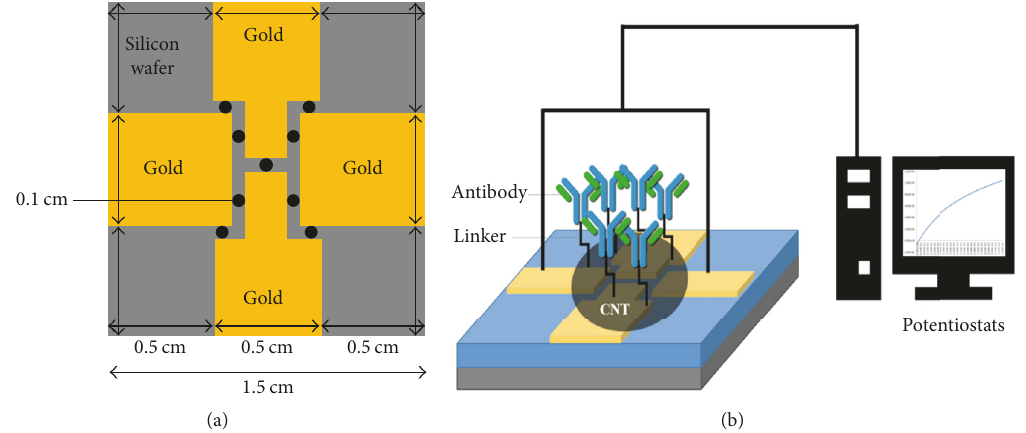
Figure 1: Platform design (a) and diagram of SWCNT-based biosensor